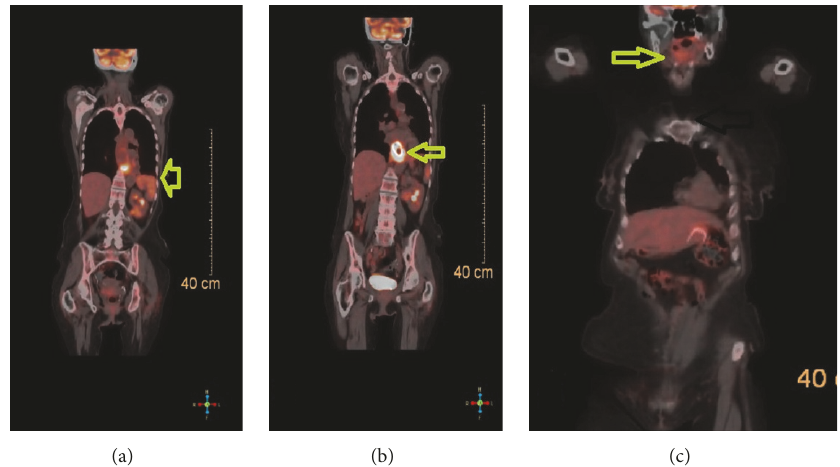
Figure3: PET scan image that was done one month after the diagnosis of thyroid RCC and esophageal adenocarcinoma .IncreasedPETactivityis appreciated within the lower esophagus. There was a lesion in the left adrenal gland which is PET avid that could represent adrenal metastasis (arrow). (b) A stent is present in the lower esophagus (arrow) crossing the GE junction into the stomach. Increased PET activity is appreciated within the lower esophagus, surrounding the esophageal stent. (c) Enlarging lesion in the right lobe of the thyroid (arrow) with increased PET activity compared to the remainder of the